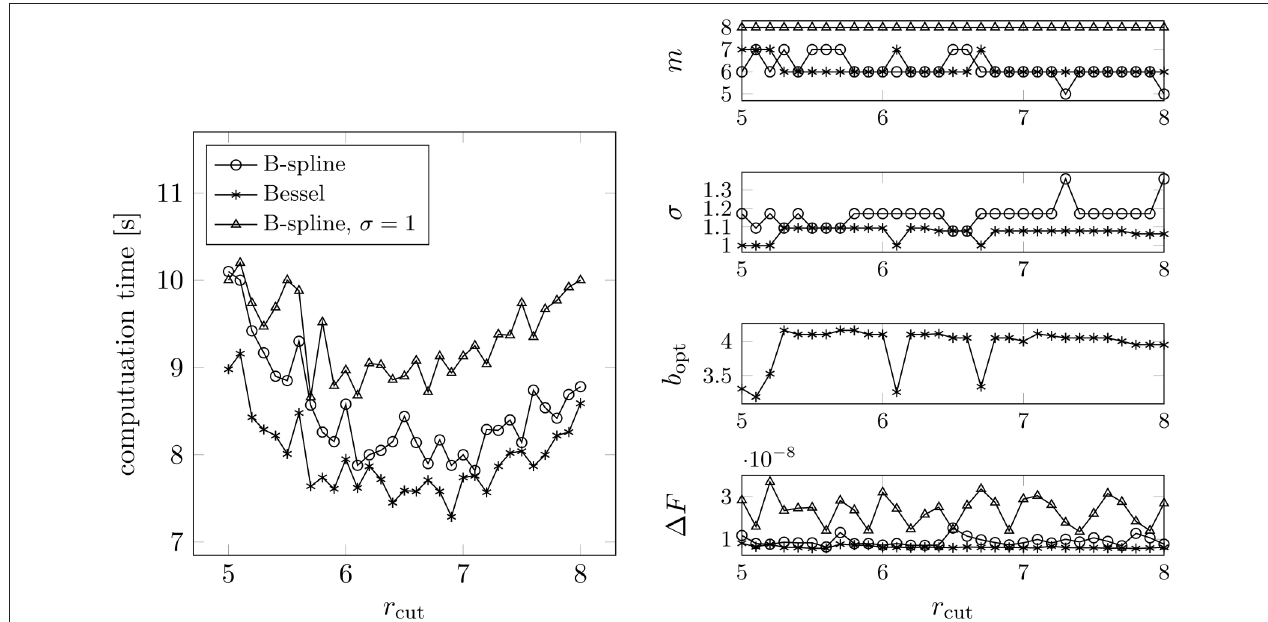
FIGURE 11 | Measured runtimes for different values of r cut (left). The required rms force accuracy was set to ε : by applying Algorithms 3.1, 4.1 and 4.2, setting N where we chose the one yielding the smallest computation time. Test case: cloud wall system, N